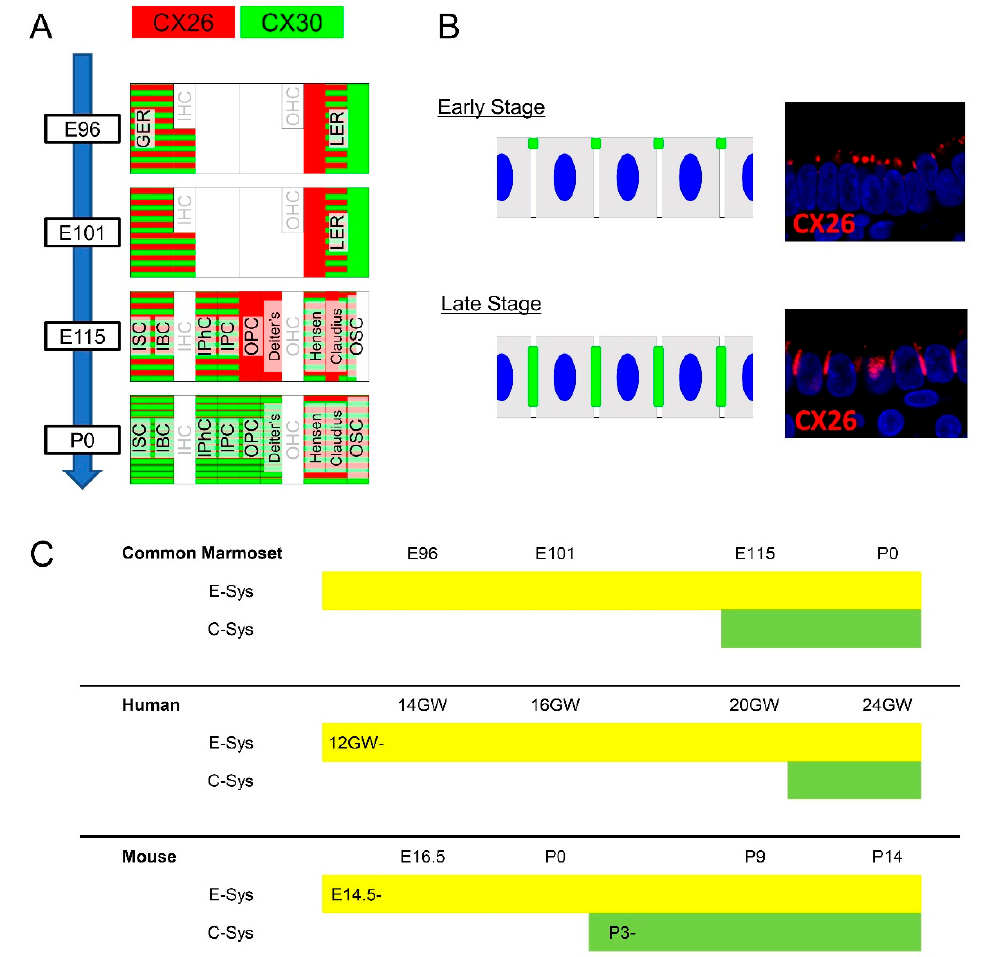
Figure 8. Schema of spatiotemporal expression patterns of CX26 and CX30 ( A ) Schema of the expression pattern of CX26 and CX30 in the organ of Corti. CX26 and CX30 showed their specific expression pattern and were not always coincident with each other. ( B ) Schema of changes in the intracellular localization of connexins. In the early stage, CXs were observed as smaller plaques at the top of lateral cell walls. In contrast, in later stages, its expression was observed as larger plaques between the cells. ( C ) Schematic diagram of expression of CXs comparing common marmoset, human, and mouse. Compared with the mouse, common marmoset and humans have a relatively longer time gap between CXs expressions in E-sys expression and C-sys expression.